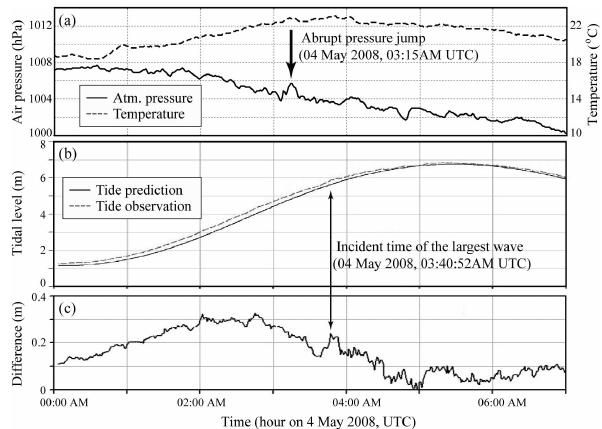
Fig. 2. (a) Variation of air pressure measured at the Boryeong AWS (Fig. 1) located close to Jukdo, (b) tidal level record and prediction at the Boryeong port located 15km north of the Jukdo pocket beach, and (c) difference between the observed and predicted tide